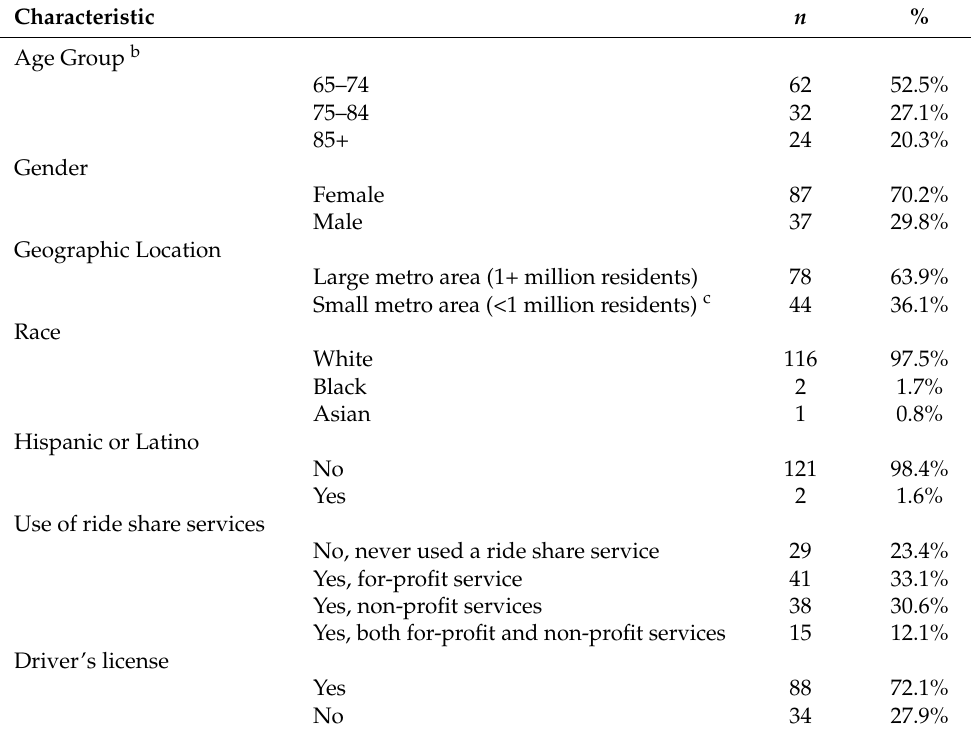
Table 1. Characteristics of older adult participants, Barriers and Facilitators of Older Adults’ Use of Ride Share Services Study, 2019, n = 124 a .